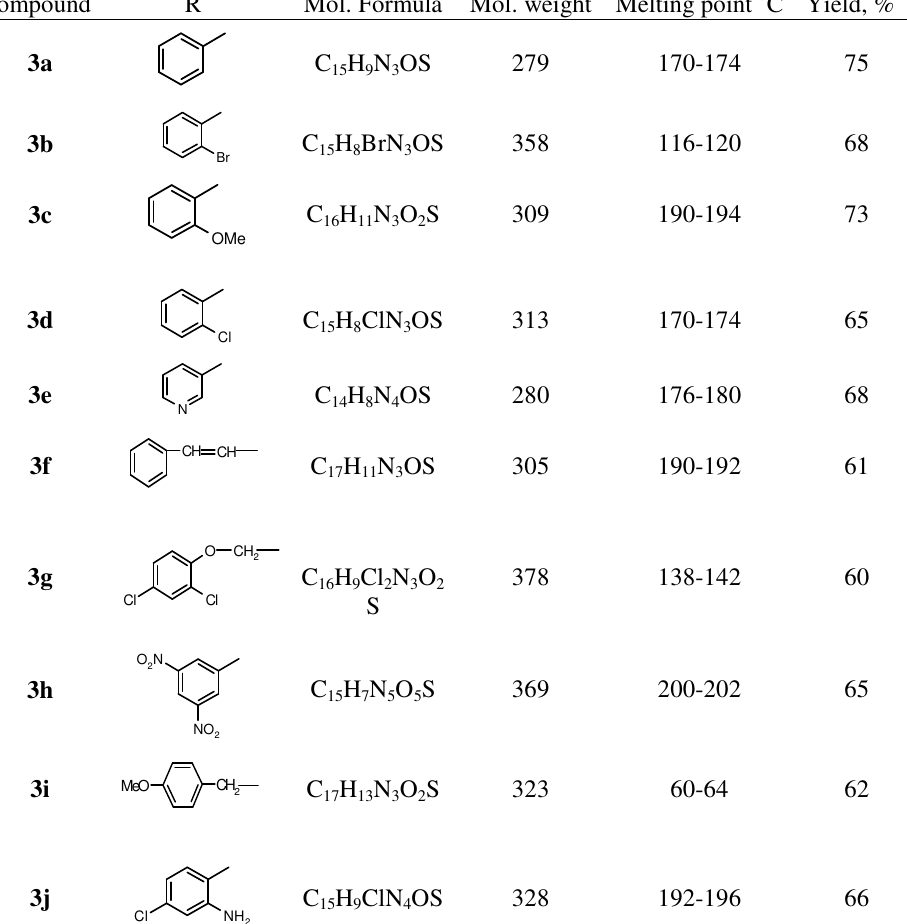
Table 1. Characterization of the compounds